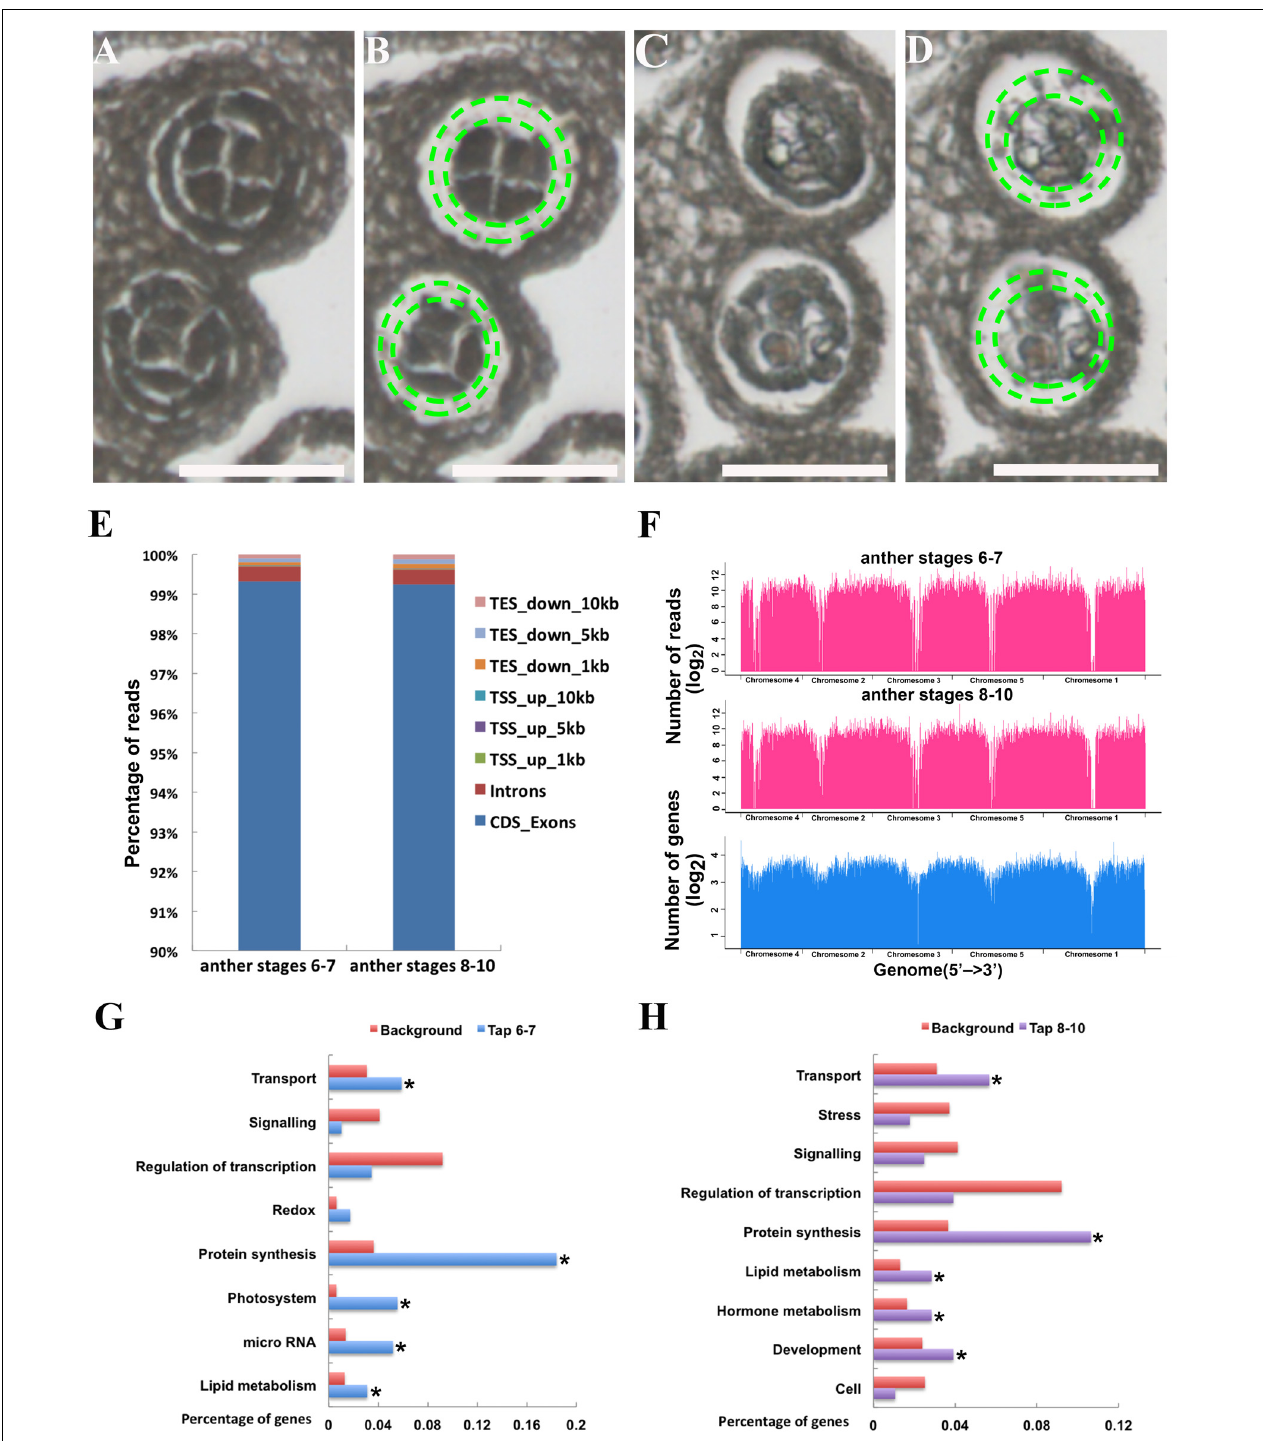
FIGURE 1 | RNA sequencing and Gene Ontology (GO) enrichment analysis of transcriptome from laser microdissection and pressure catapulting (LMPC) captured tapetal cells of anther at stages 6–7 and 8–10. (A) Wild-type Col-0 anther at stages 6–7 before LMPC. (B) Wild-type Col-0 anther at stages 6–7 after LMPC, tapetal cells were isolated. (C) Wild-type Col-0 anther at stages 8–10 before LMPC. (D) Wild-type Col-0 anther at stages 8–10 after LMPC, tapetal cells were isolated. (E) Reads distribution in different gene area. Over 99% of the reads were mapped in the CDS_Exons. TES, transcription termination site; TSS, Transcription start site; CDS, coding DNA sequence. (F) Reads distribution in the whole genome, compared with the gene distribution in the whole genome. (G) GO enrichment analysis of tapetum expressed genes at anther stages 6–7. (H) GO enrichment analysis of tapetum expressed genes at anther stages 8–10. Asterisk indicates P values < 0.05 compared with